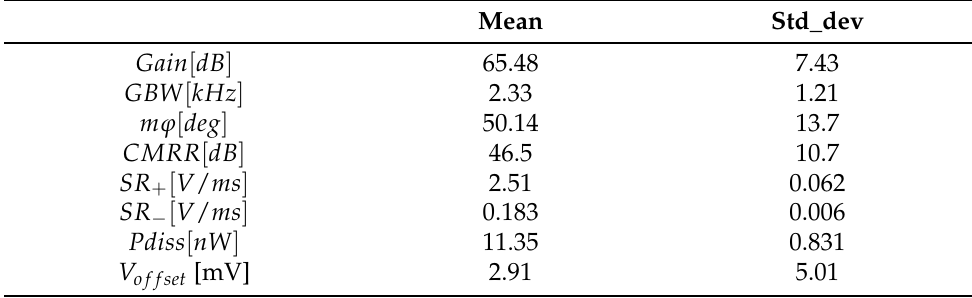
Table 5. Monte Carlo